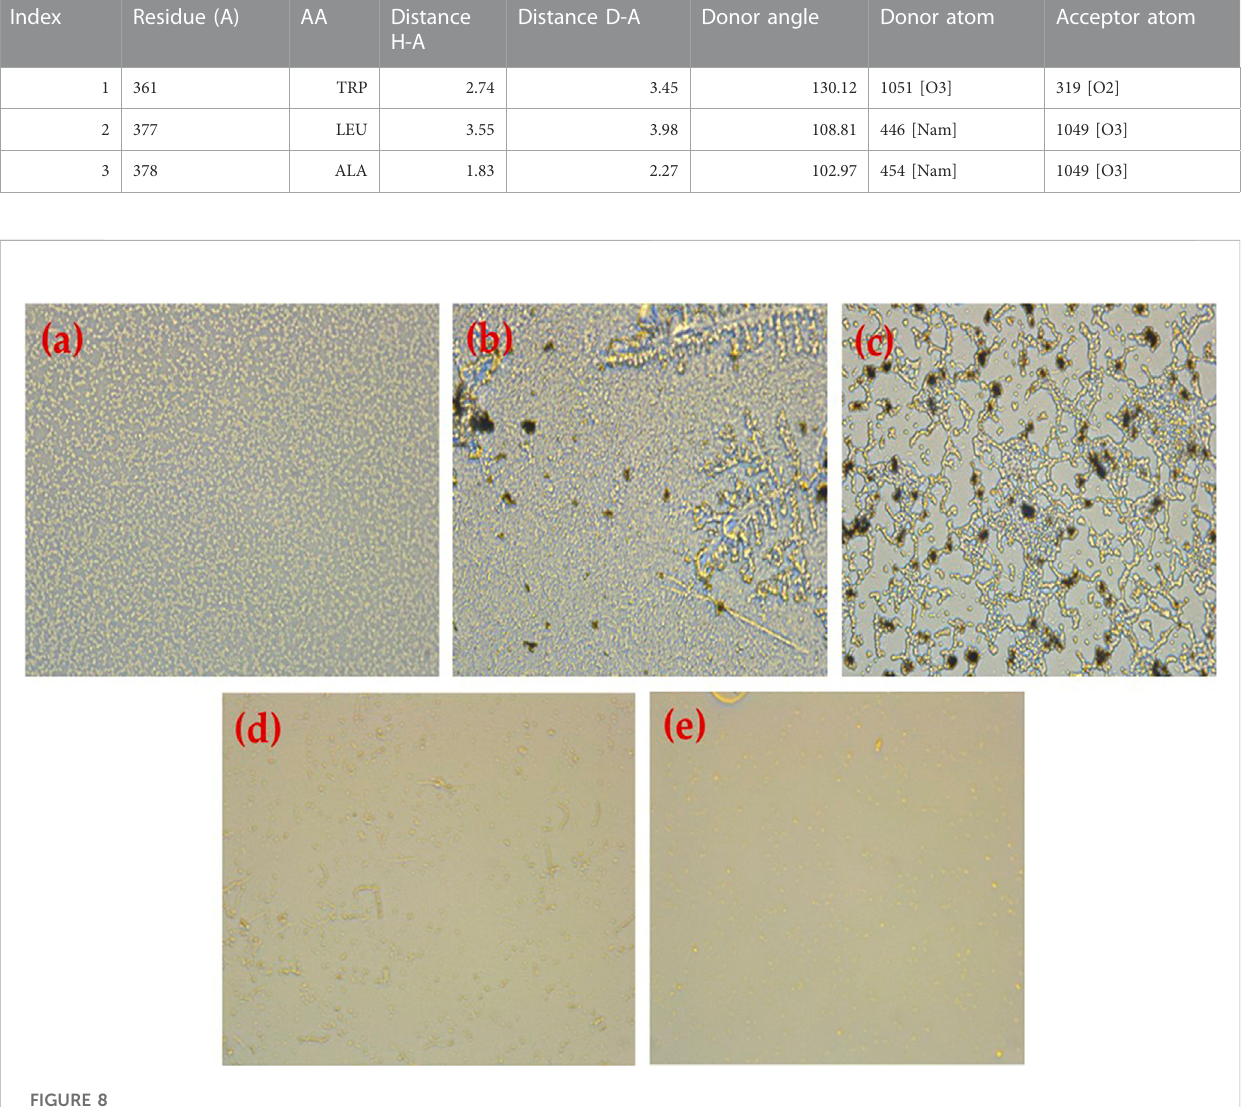
FIGURE 8 Results obtained using an inverted microscope (40) (A) untreated P. aeruginosa bio fi lm, (B) P. aeruginosa treated with HRG 100 (µg/mL), (C) P. aeruginosa treatedwithHRG200(µg/mL), (D) P.aeruginosa treatedwithAmpicillin1 mg/mL,and (E) P.aeruginos treatedwithGentamycin(100 mg/mL).